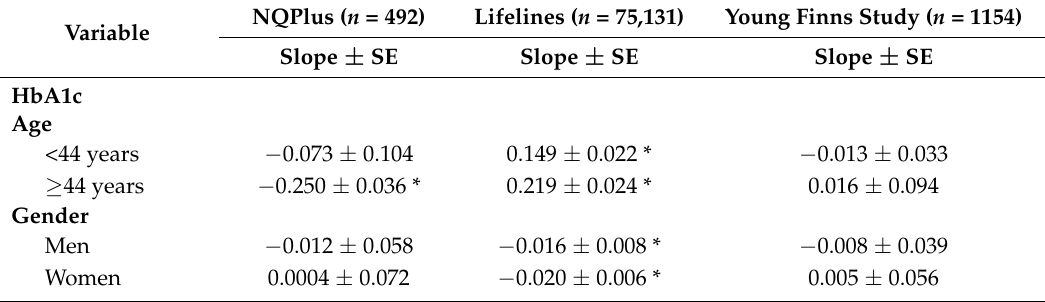
Table 3. Stratified analyses of the associations of HbA1c and eGFR (estimate ±